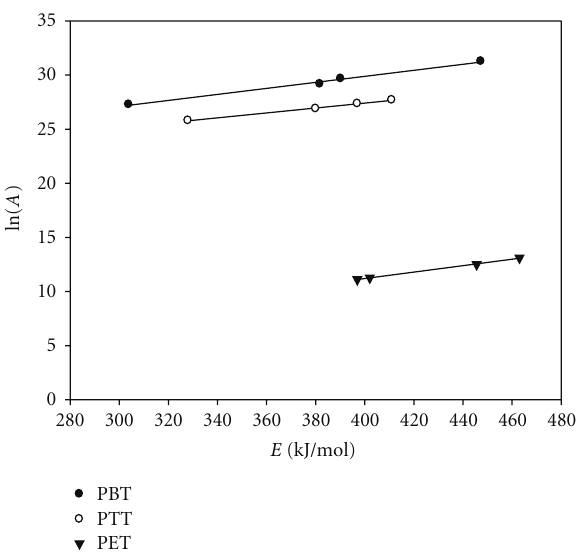
Figure 7: Plot indicating a linear relationship of Δ S versus E for di ff erent polyesters degraded in air atmosphere (zone 1).